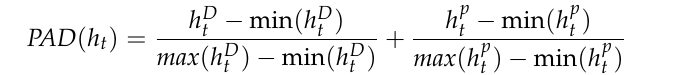
generated by dataset training is